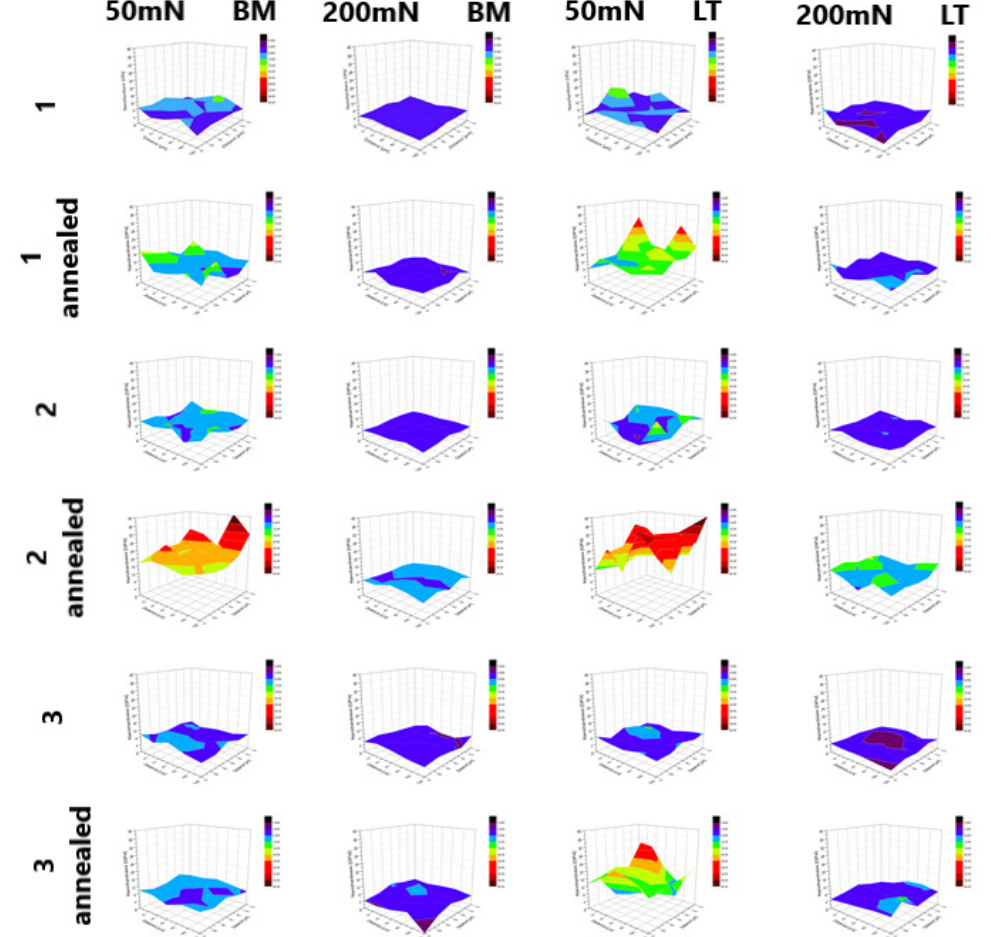
Materials 2021 , 14 , x FOR PEER REVIEW Figure 8. Three-dimensional hardness maps of the BM, LT and annealed BM and LT samples. Figure 9 shows the numerical values of the hardness obtained after melting.